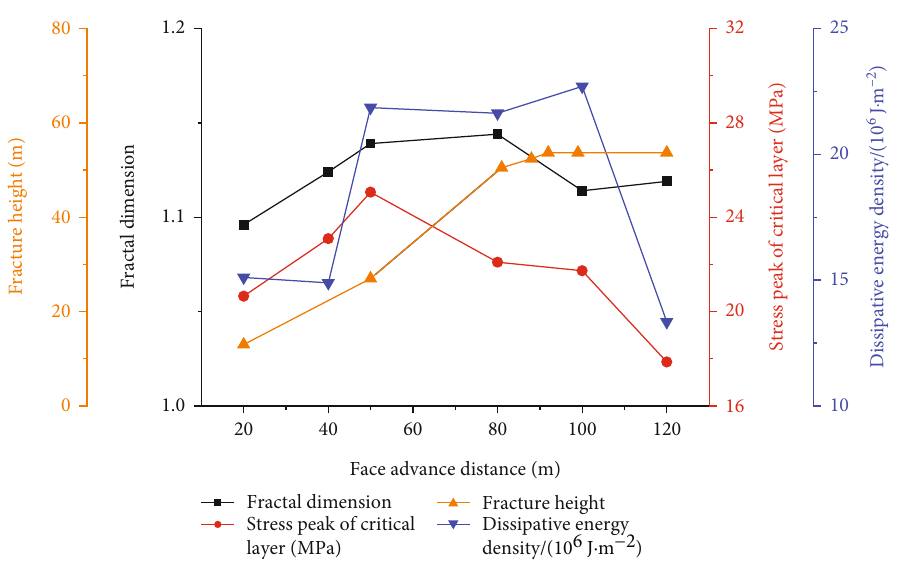
Figure 11: Relationship curves between key fracture fi eld, stress fi eld, and energy fi eld